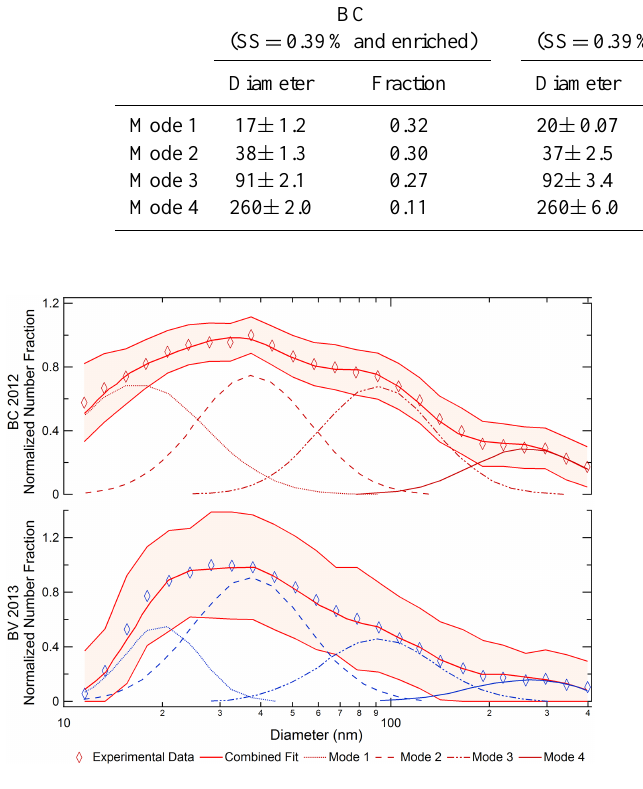
Figure 1. Average size distributions for each campaign (Bay of Calvi, BC, and Bay of Villefranche, BV) fit with four lognormal modes. Each campaign average is taken from the supersaturations (SS = 0.08% and 0.39%) used for all three mesocosms and in- cludes all enriched samples as well.